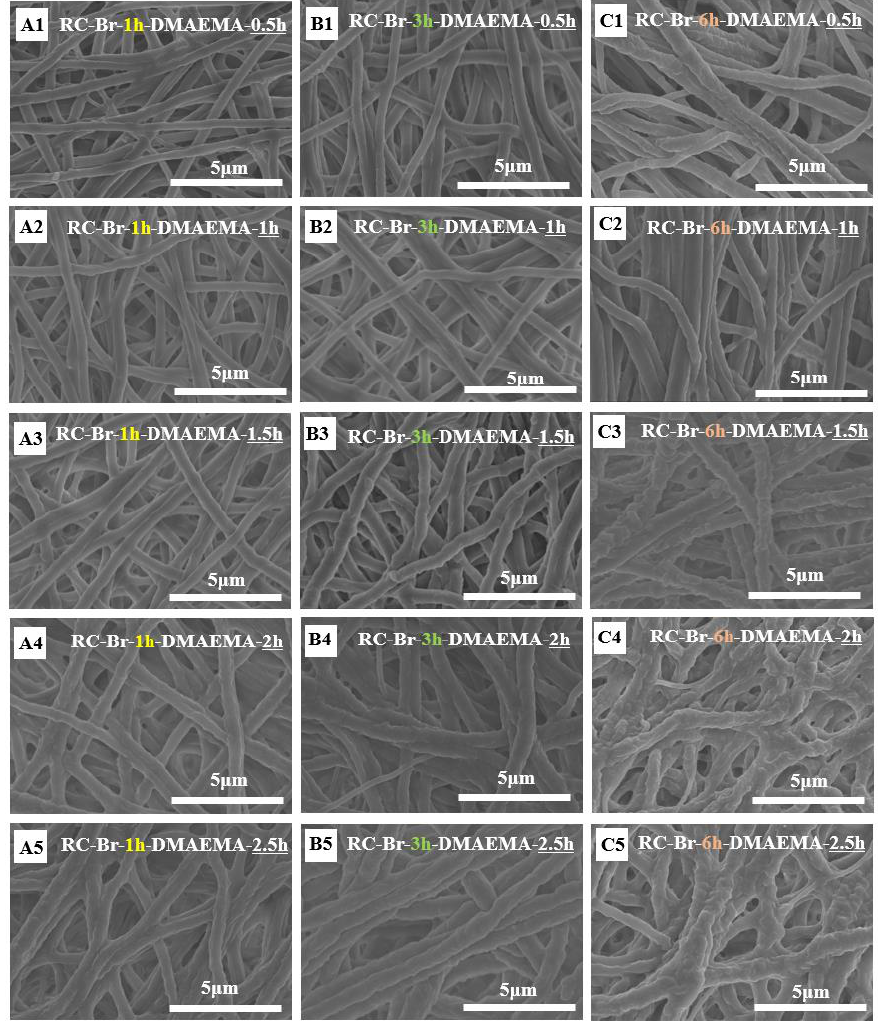
Figure 6. SEM images showing the morphological structures of the DMAEMA-modified RC membranes with initiation times of ( A1 – A5 ) 1 h, ( B1 – B5 ) 3 h, and ( C1 – C5 ) 6 h, as well as with different polymerization reaction times of 0.5, 1, 1.5, 2, and 2.5 h.